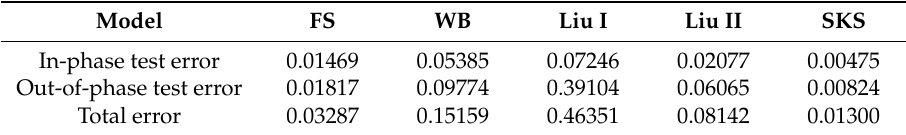
Table 7. Summary of the relative error between DP exp and DP calc for each model.